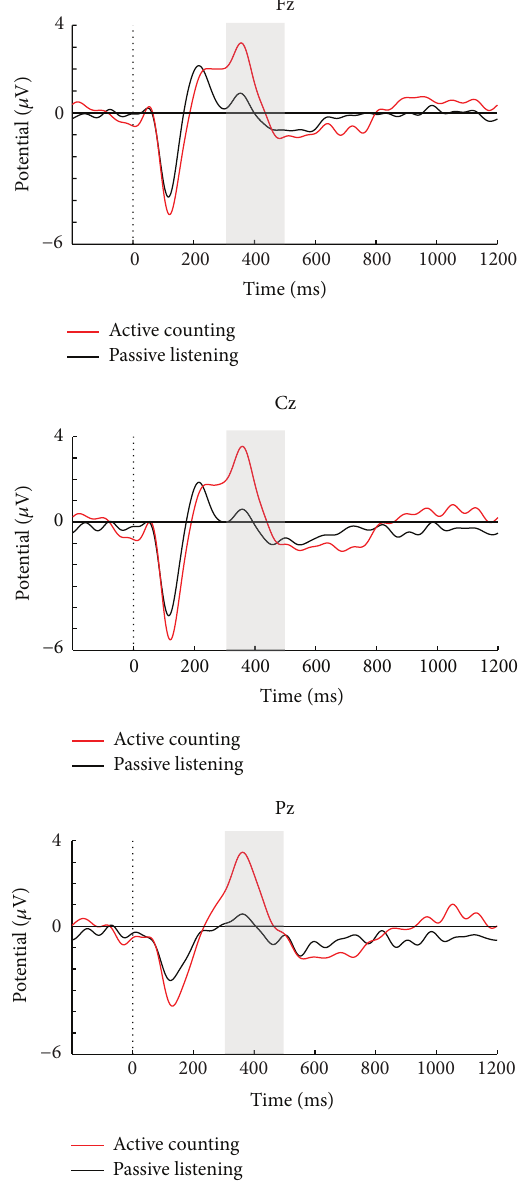
Figure 4: Passive and active conditions in task 2 for the healthy